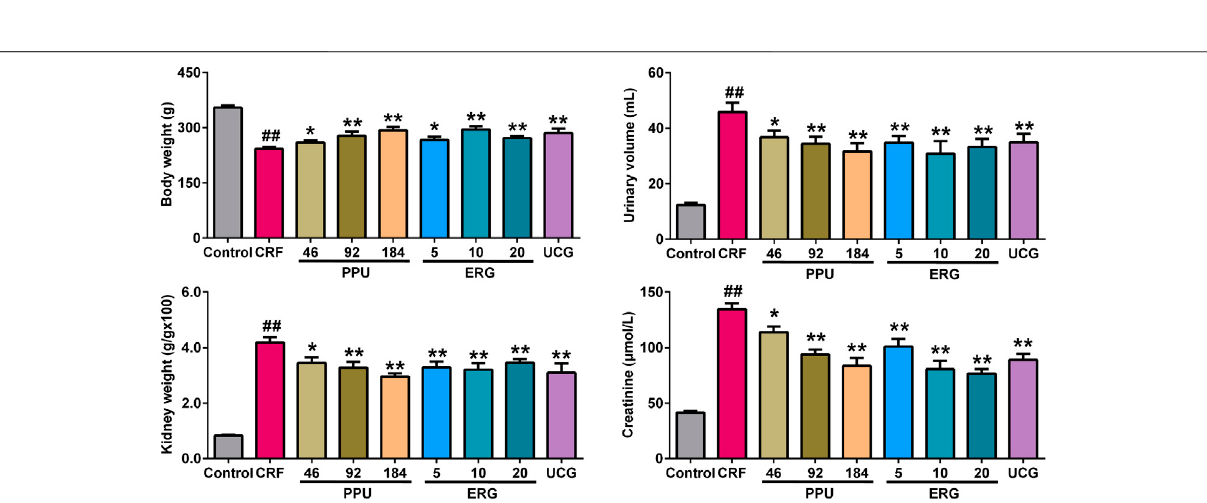
Frontiers in Pharmacology |